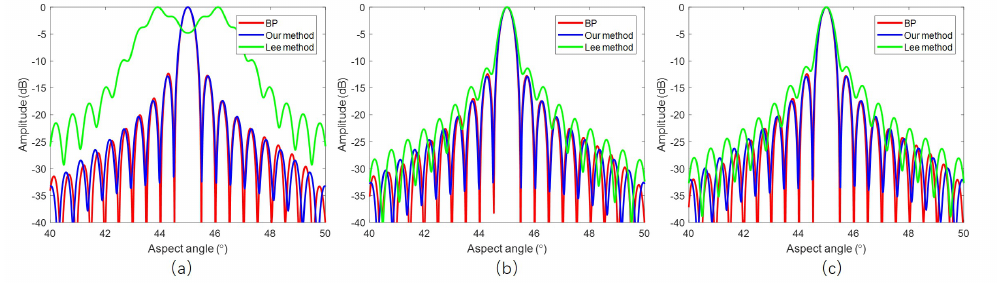
Figure 10. Azimuth profiles: ( a ) Profiles of Near range target. ( b ) Profiles of center range target. ( c ) Profiles of far range